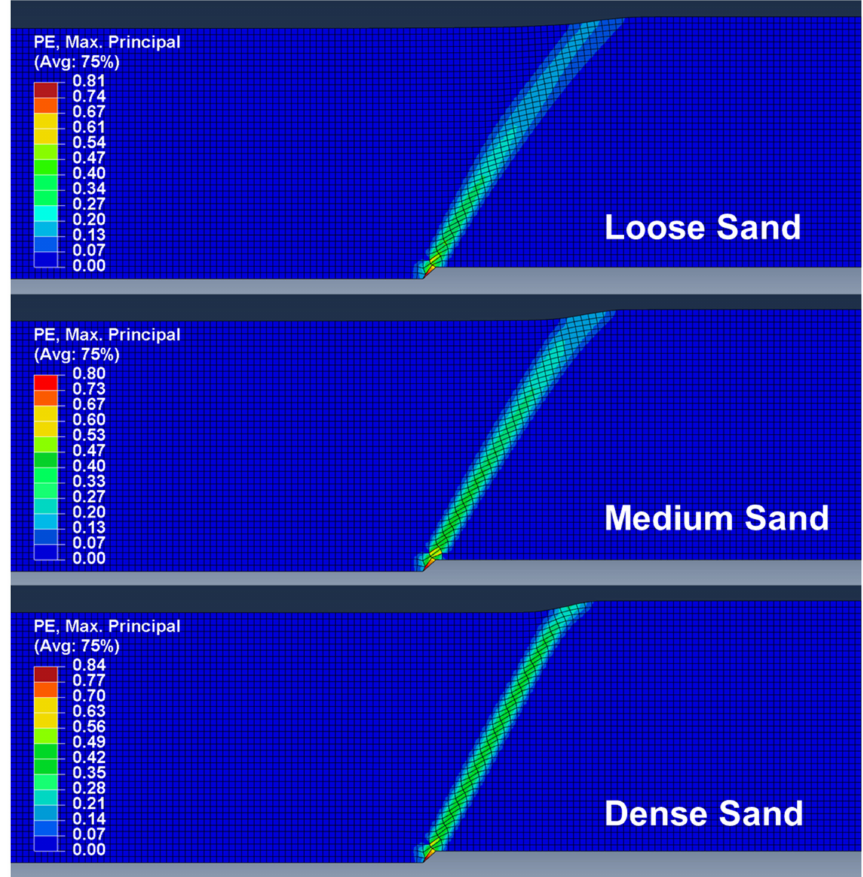
Figure 7. FE results of fault rupture, fault rupture propagation, and fault outcropping.